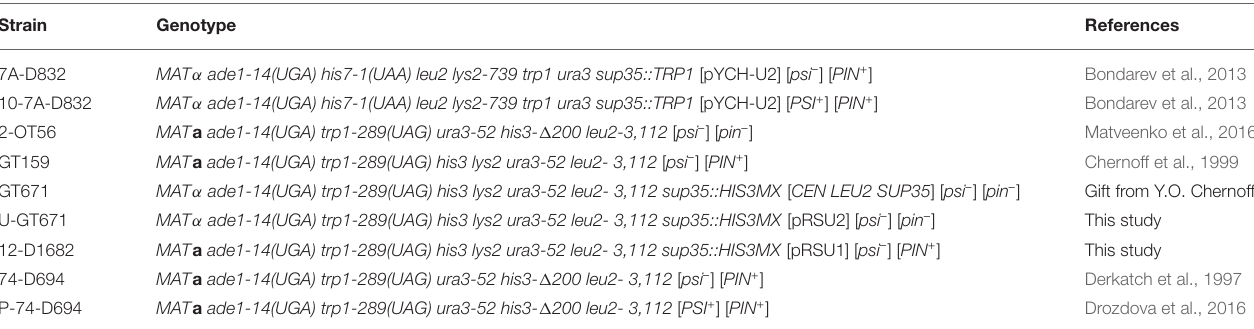
TABLE 1 | Strains of S. cerevisiae used in this